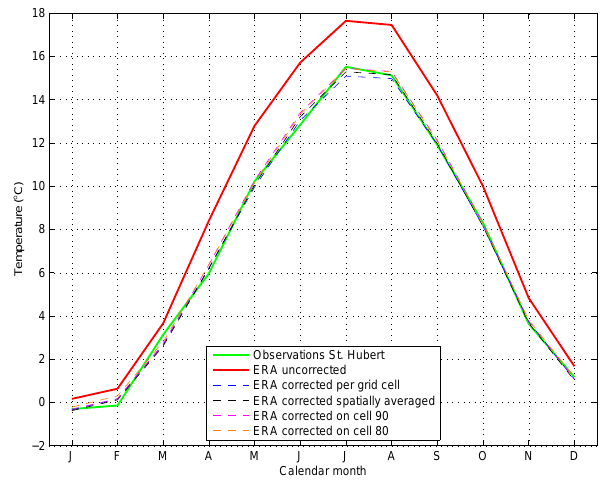
Fig. 3. Mean monthly precipitation sums of the observations and (un)corrected datasets for the period 1979–1996.